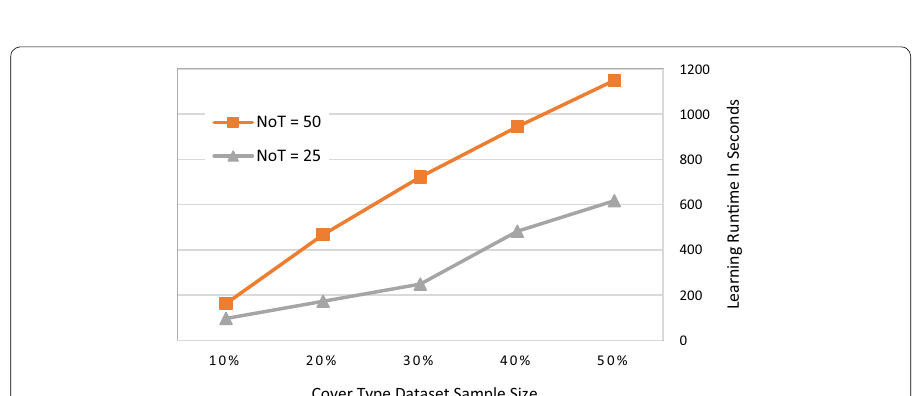
Fig. 13 Scalability results. Learning runtime for increasing training dataset